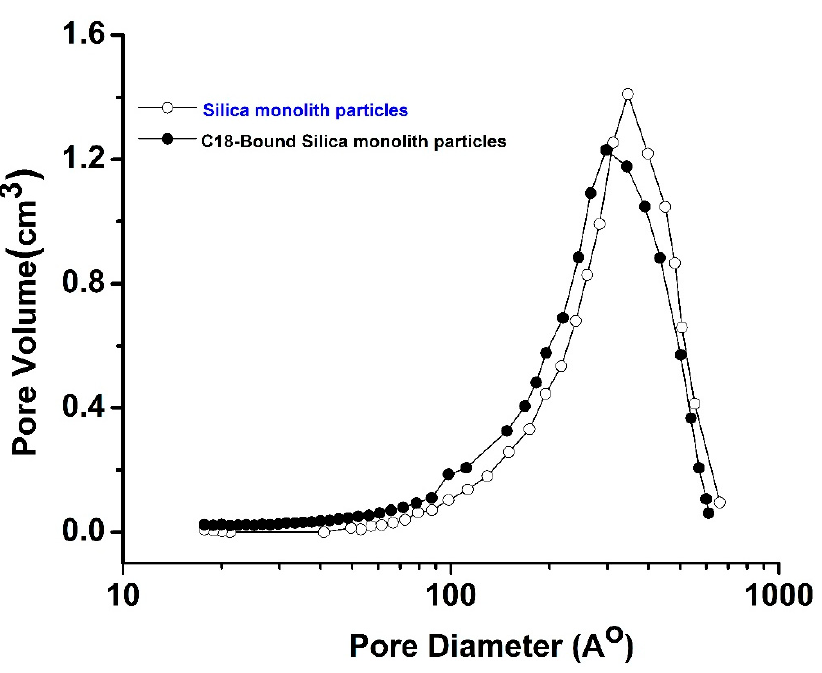
Figure 3. Pore-size distribution of bare and C18-bound SM particles. Table 2. The pore size, pore volume, and surface area analysis of current and previous SP. Bare SM Particles C18-Bound SM Particles Pore Size (Å) Pore size (Å)